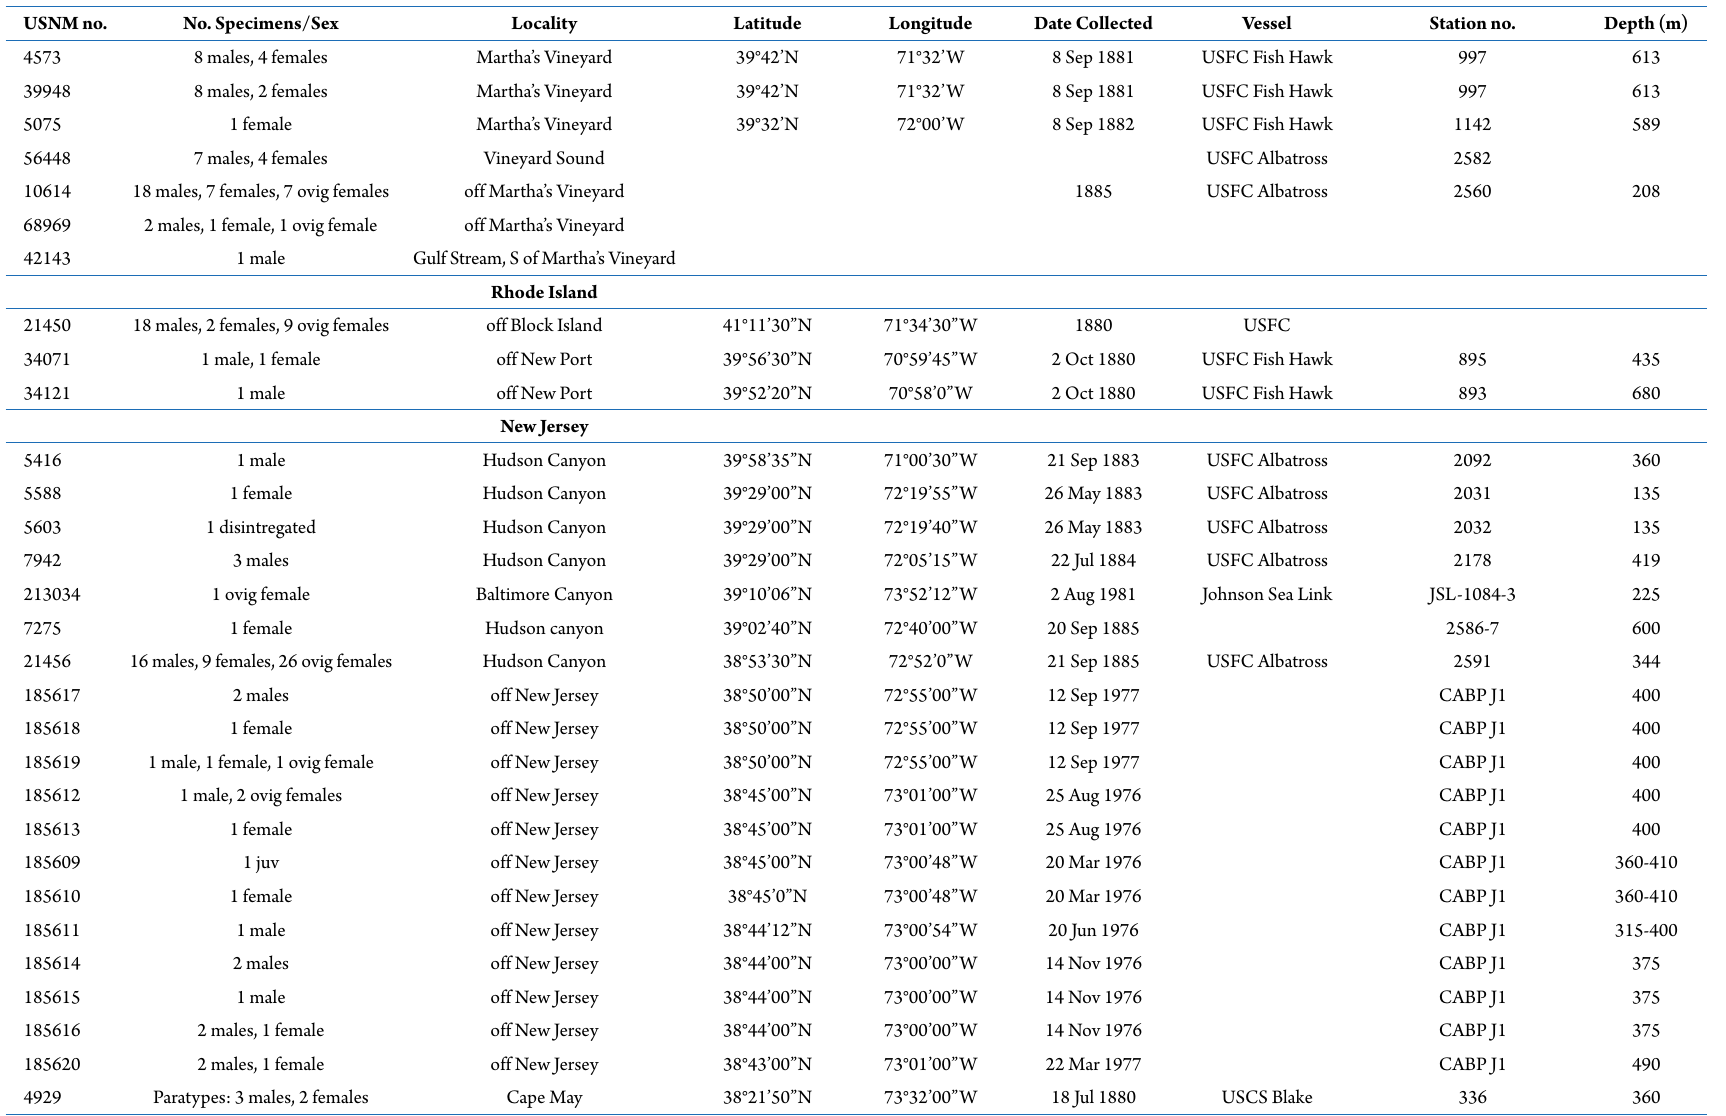
Table 1. Cont. USNM